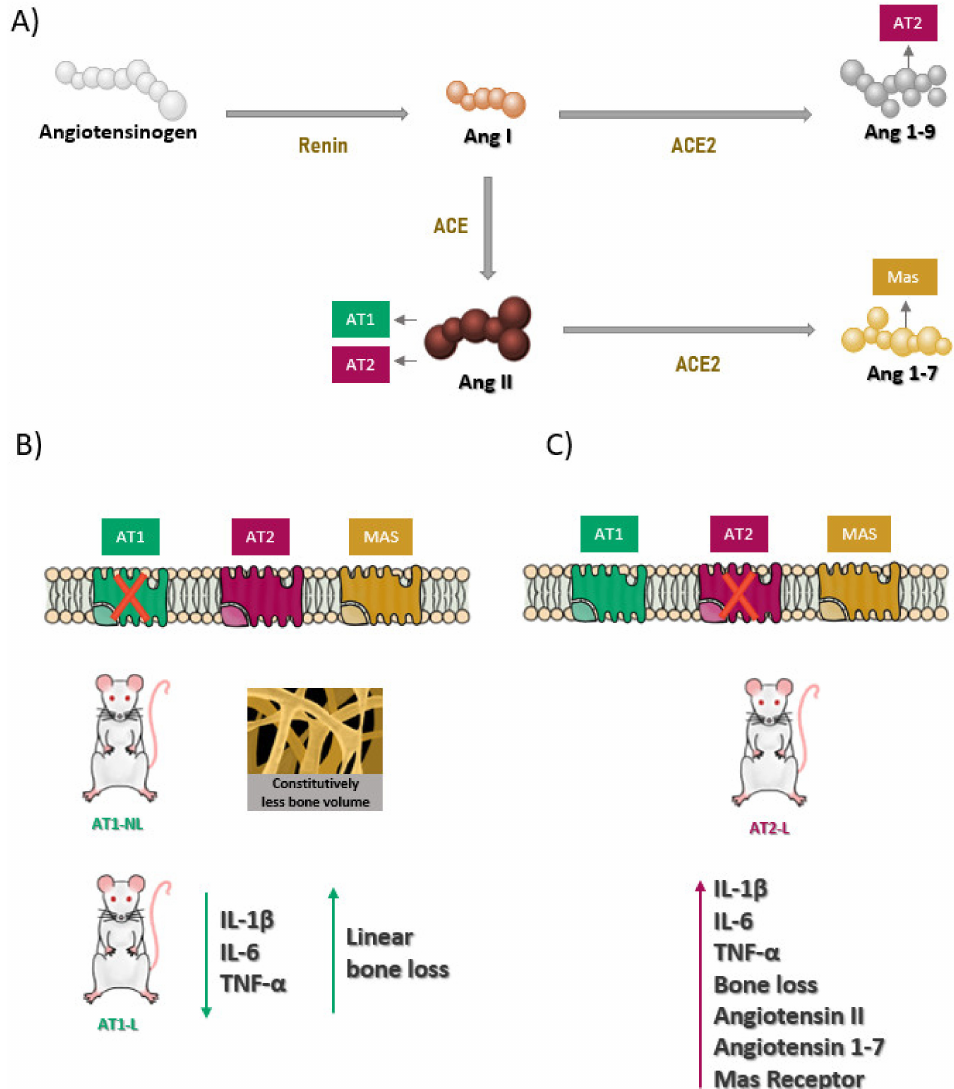
Figure 4. ( A ) Pathways of the renin-angiotensin system in the wild-type animal; ( B ) free pathways of the renin-angiotensin system for AT1 receptor knockout animals and changes in cytokine levels after induction of periodontitis by ligation; ( C ) free pathways of the renin angiotensin system for AT2 receptor knockout animals and changes in cytokine levels and in RAS (Angiotensin II and Angiotensin 1-7), Mas receptor after induction of periodontitis by